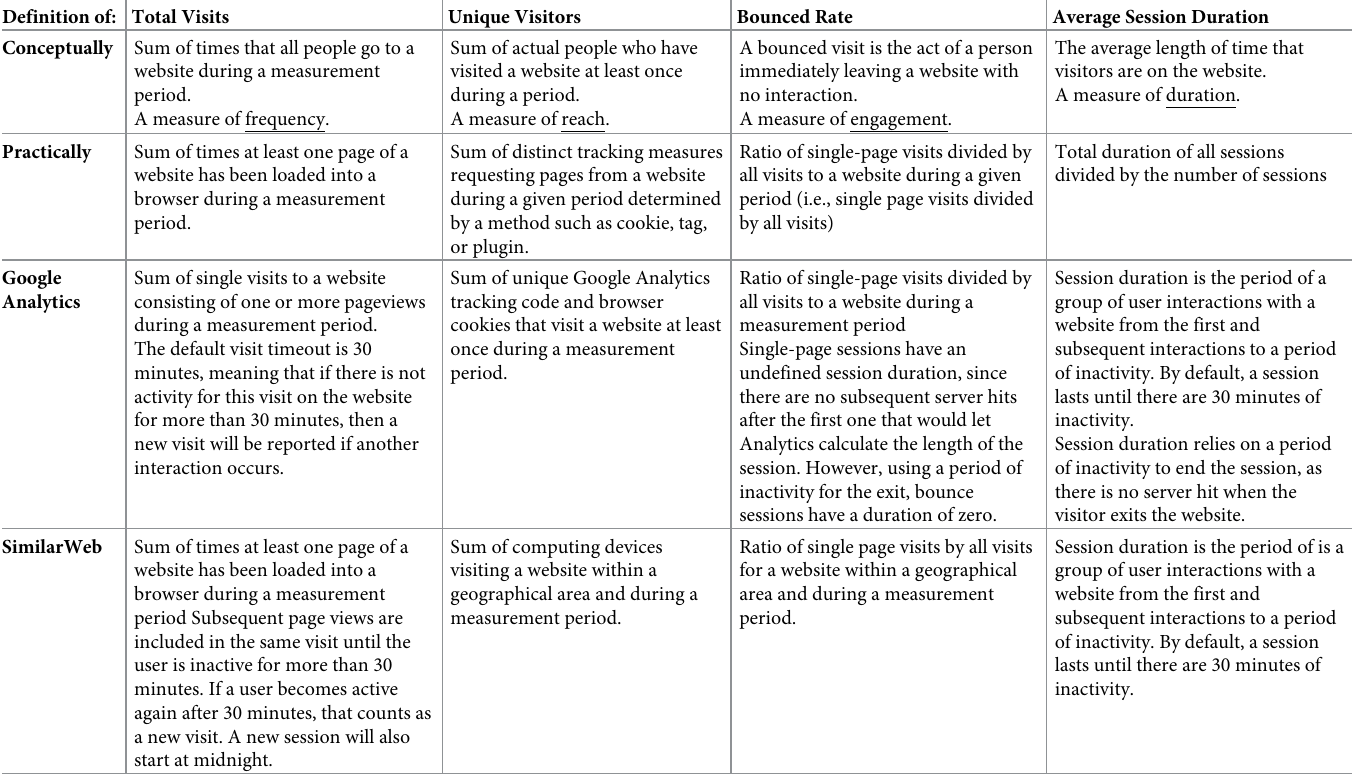
Table 2. Comparison of definitions of total visits, unique visitors, bounce rate, and session duration conceptually and for the two analytics platforms: Google Ana- lytics and SimilarWeb. Definition of: Total Visits